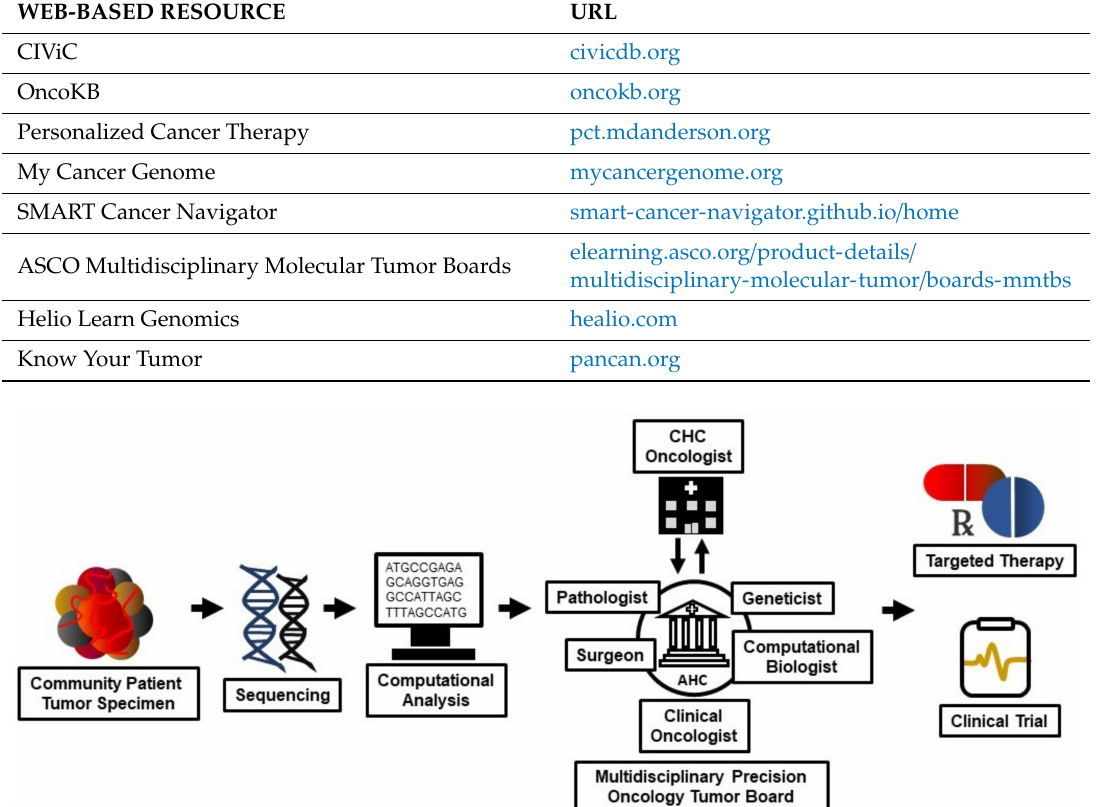
Figure 2. Multidisciplinary precision oncology tumor boards (POTBs) provide expert targeted drug matching and molecularly informed clinical trial enrollment for community oncology patients. Tumor specimens from community patients undergo nucleic acid sequencing with computational analysis to identify molecular alterations; this information provides a basis to discover candidate targeted therapies and determine clinical trial eligibility. An academic health center (AHC) POTB comprising, among others, clinical oncologists, pathologists, surgeons, geneticists and computational biologists, in consultation with community health center (CHC) oncologists, reviews patients’ clinical cases and their sequencing results to select appropriate targeted therapies and clinical